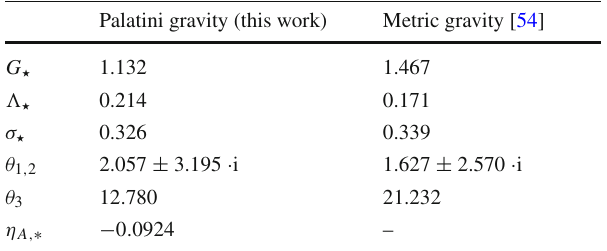
Table 1 Fixed-point solutions and critical exponents in second order truncation for Hilbert–Palatini gravity (this work) and metric gravity for the present truncation [54] Palatini gravity (this